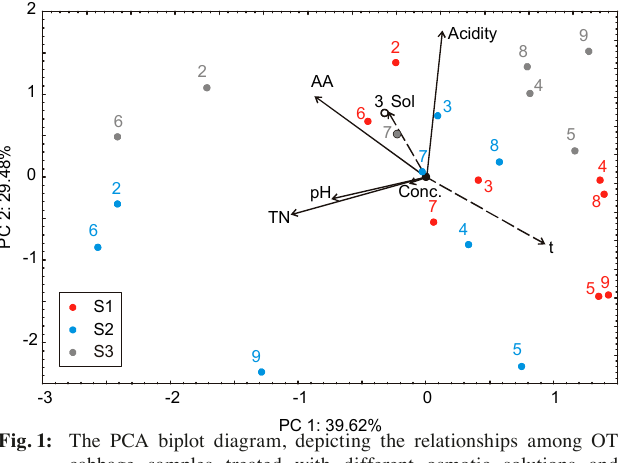
Fig. 1: The PCA biplot diagram, depicting the relationships among OT cabbage samples treated with different osmotic solutions and packaged in different MAP during storage. Sol − osmotic solution; CO 2 -N 2 content in the MAP; T − storage time; AA − ascorbic acid (mg/100 g); TN − a total number of micro- organisms (cfu/g)